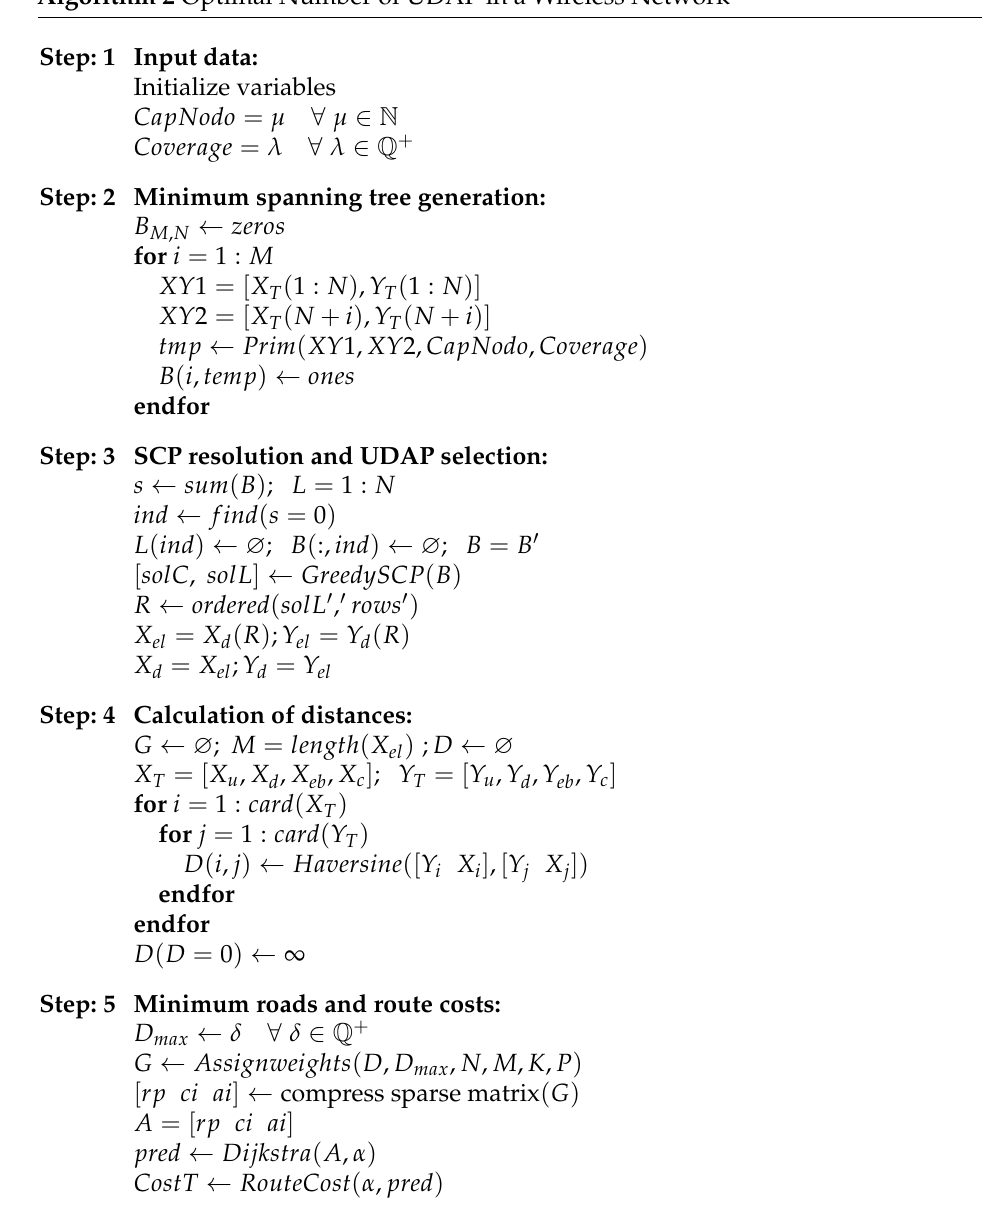
Algorithm 2 Optimal Number of UDAP in a Wireless